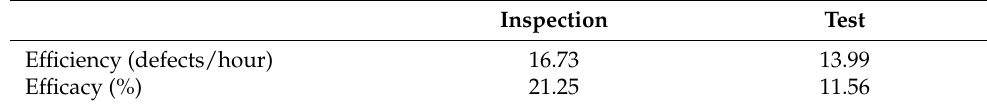
Table 19. The efficiency and